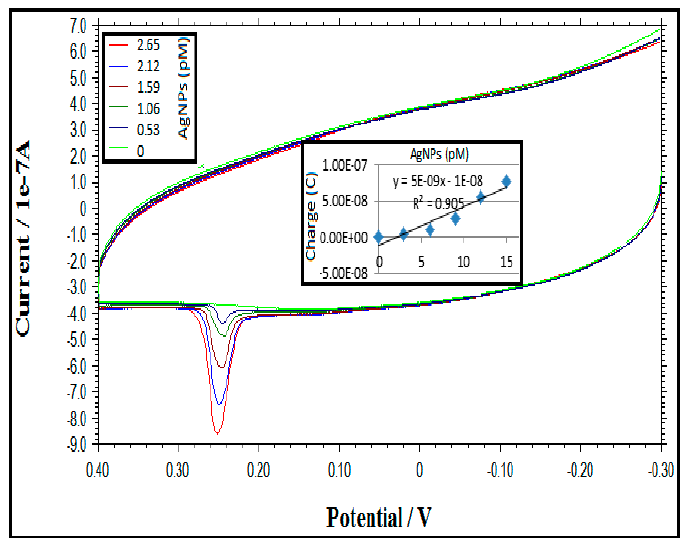
Figure 3. DNA ASV graphic and calibration curve compared with various dilutions of AgNPs.